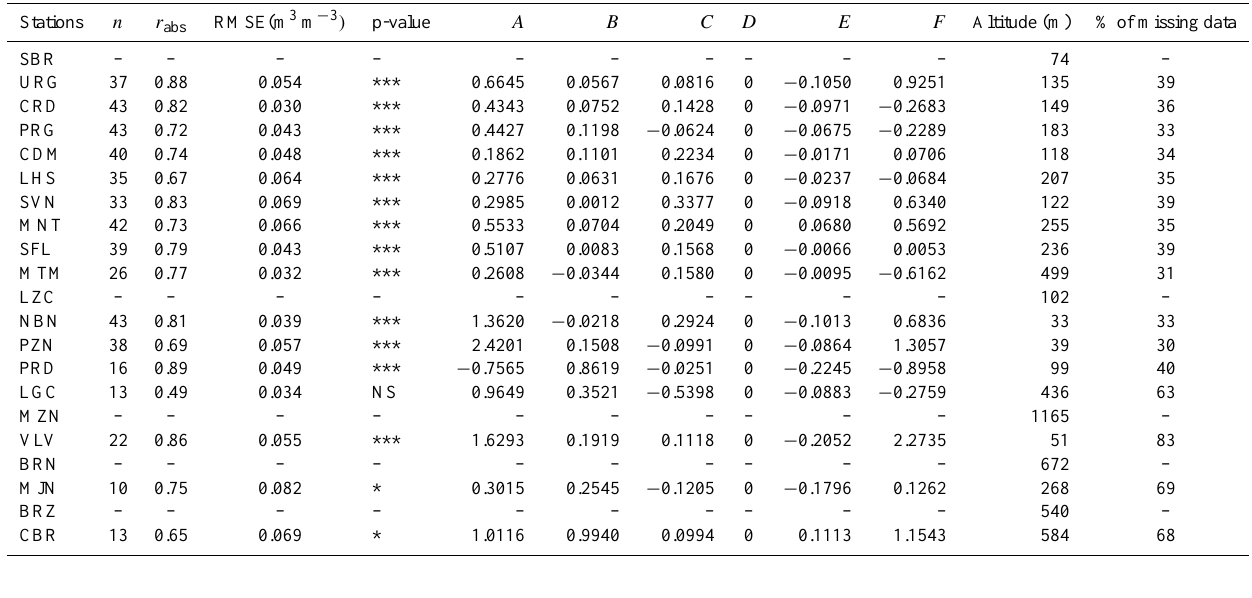
Table 3. Comparison between the in situ SSM and the SSM retrieved from the SMOS-L1 T b using the regression coefficients ( A , B , C , D , E , F ) of Eq. (2) derived from the in situ SSM: number of points used in the regression ( n) , correlation coefficient ( r abs ), root mean square error (RMSE) and p-value. The fraction of missing data caused by the RFI filtering is indicated. NS stands for non significant, and *, **, *** stand for p-values greater than 0.05, between 0.05 and 0.001, and between 0.001 and 0.0001, respectively.